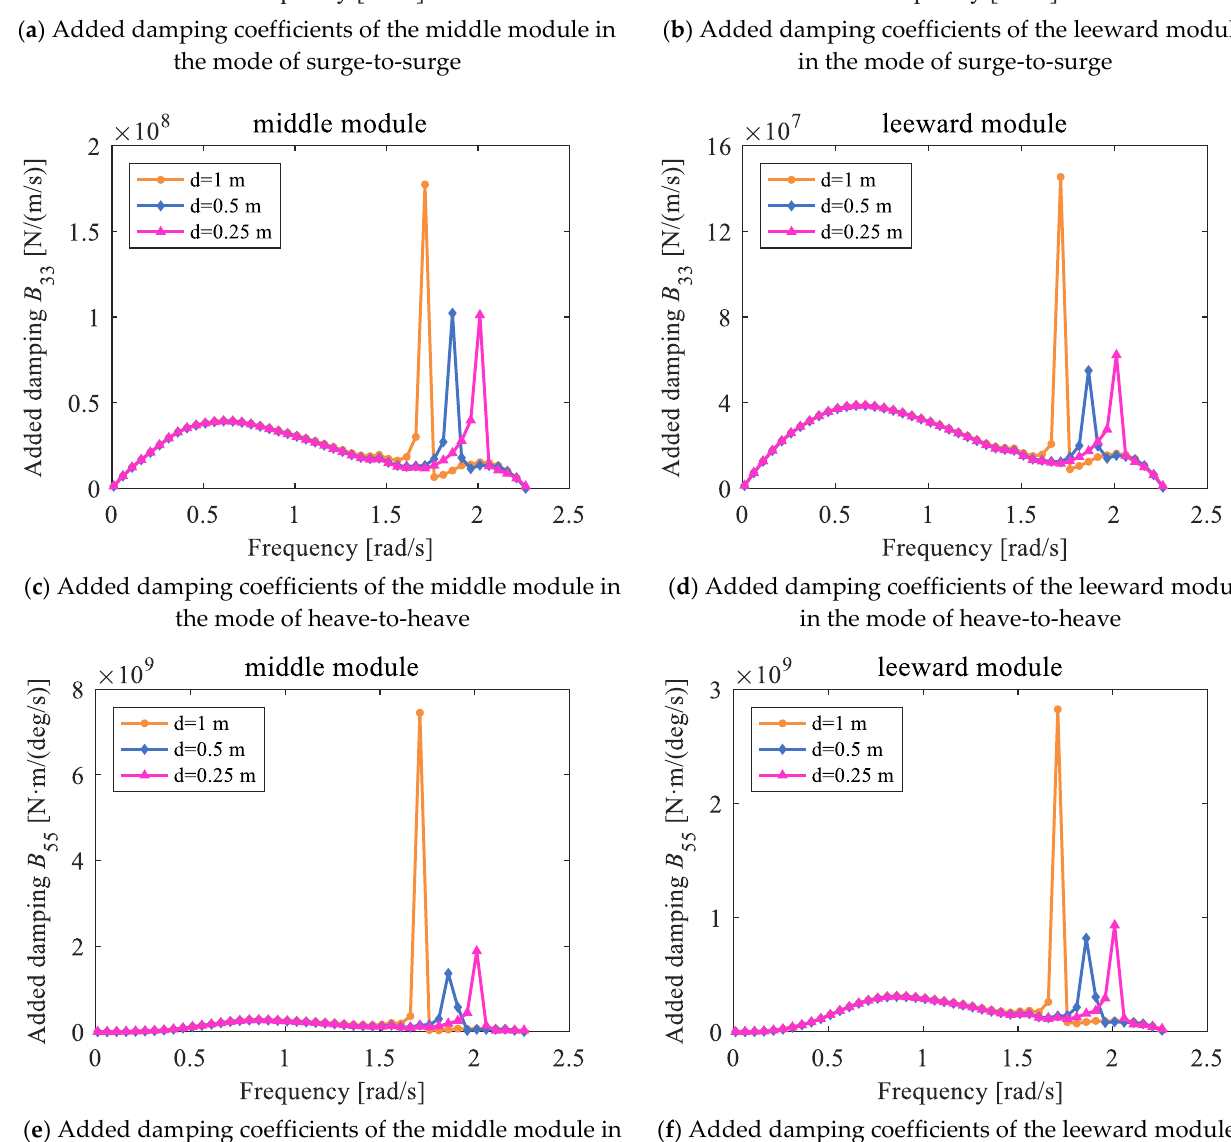
Figure 8. Damping term of two different modules in the 3-module model with different gap widths.